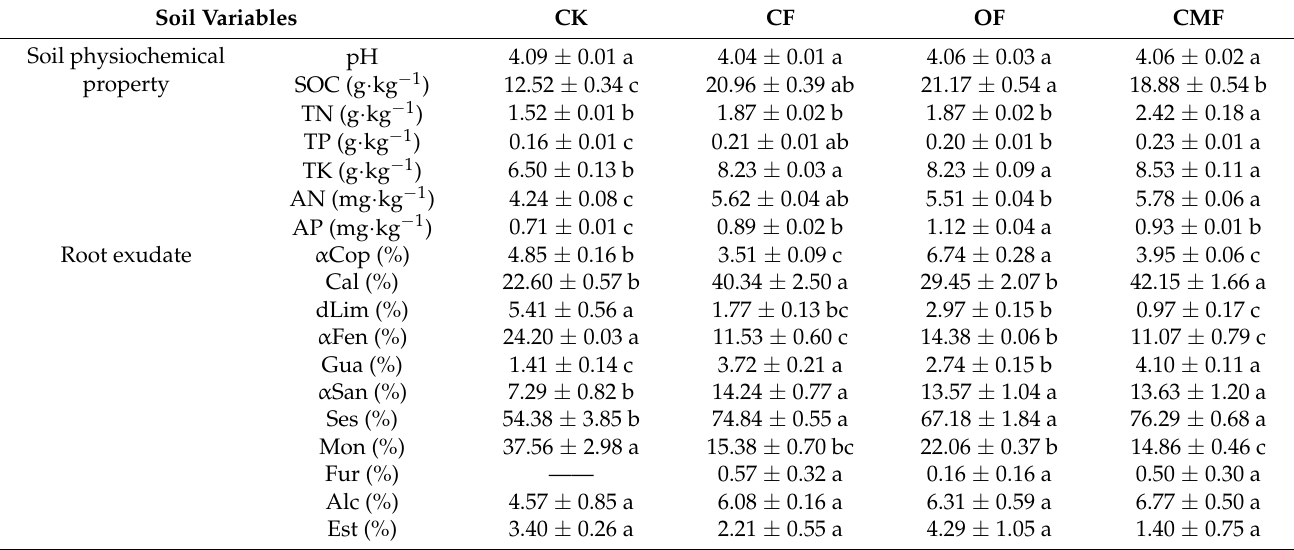
Table 1. The soil physiochemical properties and root exudates under four fertilizer regimes. Soil Variables CK CF OF